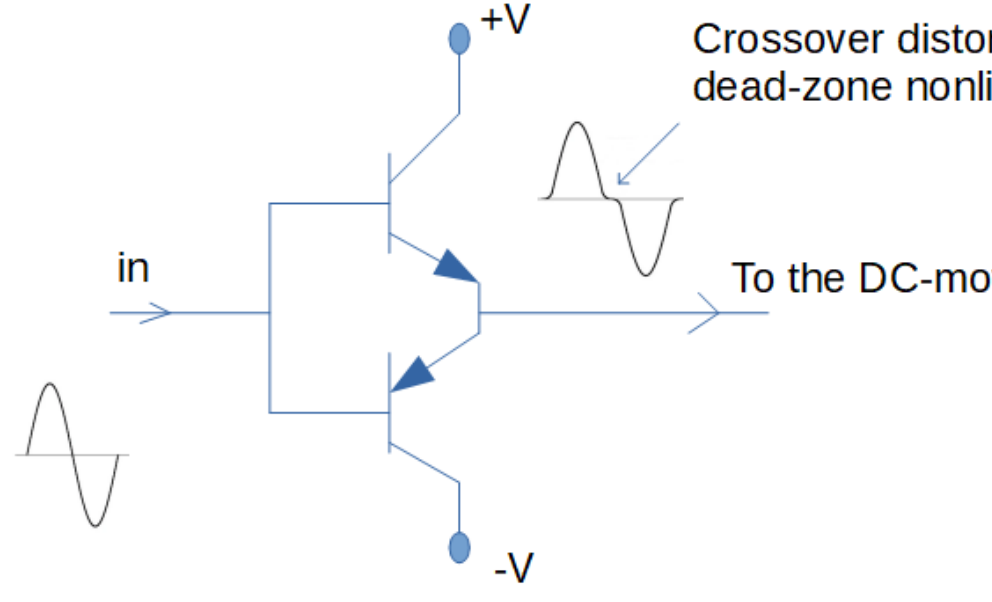
Figure 18. Illustration of the cross-over distortion which actually is the dead-zone